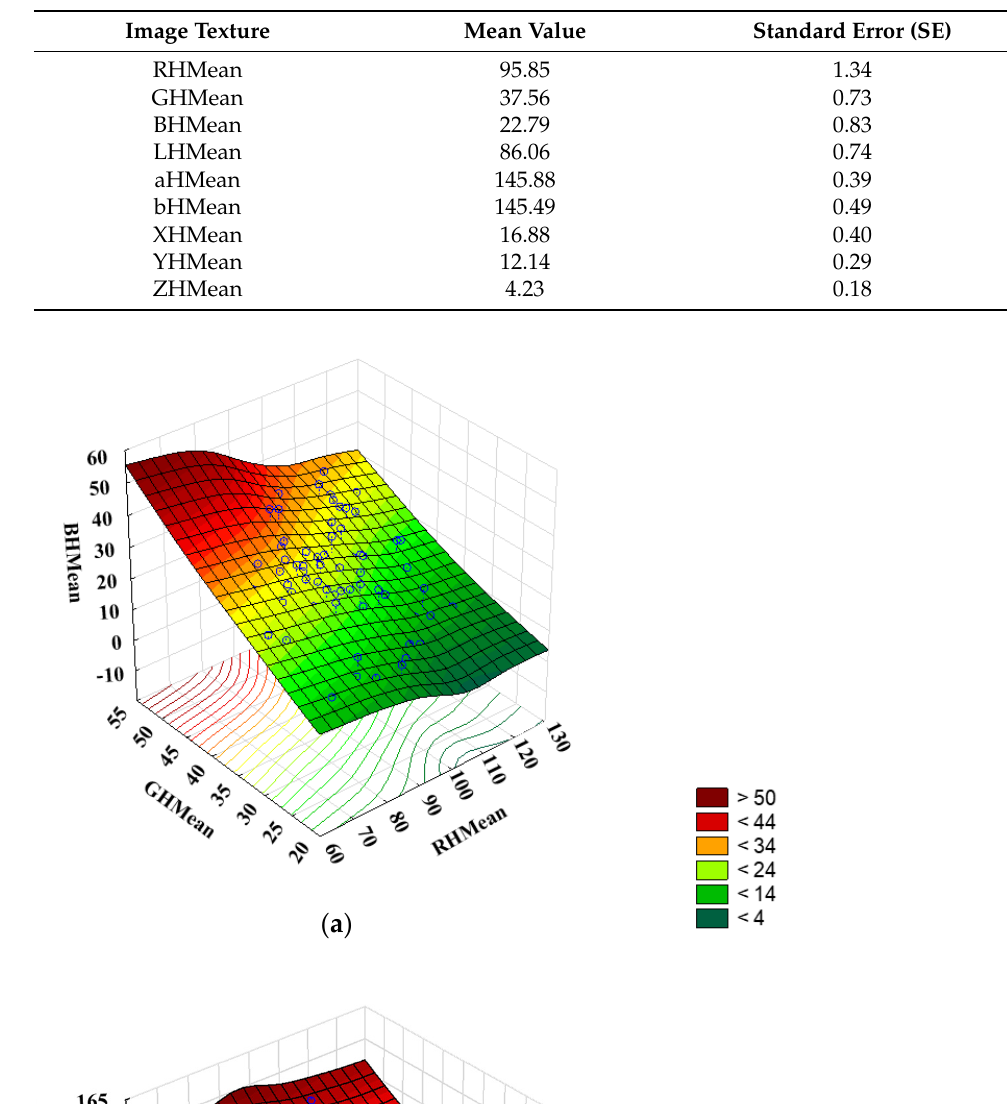
Table 1. Mean values of selected image texture parameters of ‘Mejhoul’ date fruit.